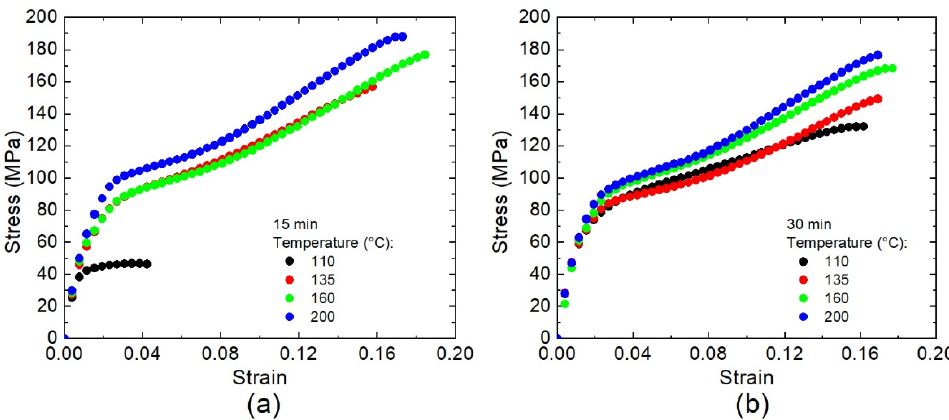
Figure 13. Stress–strain for [±45°] WCFF/Aerotuf composite laminates molded for ( a ) 15 min; ( b ) 30 min, at several curing temperatures.